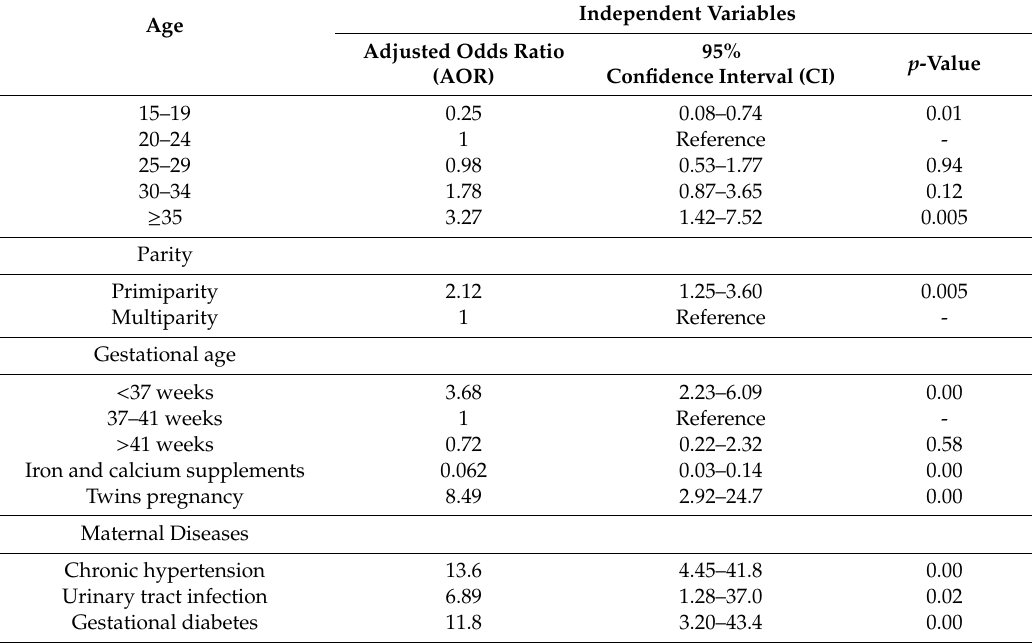
Table 2. Multivariable analysis of factors associated with